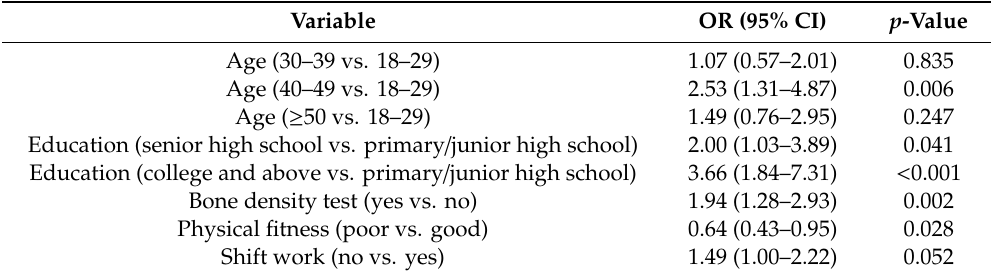
Table 6. Multiple logistic regression of health literacy level of osteoporosis risks ( n =